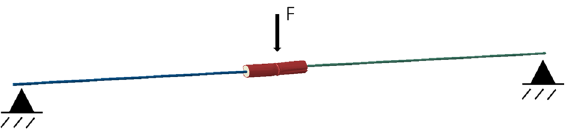
Figure 4. The solid continuum sub-model computationally stitched in to a three-point bending beam